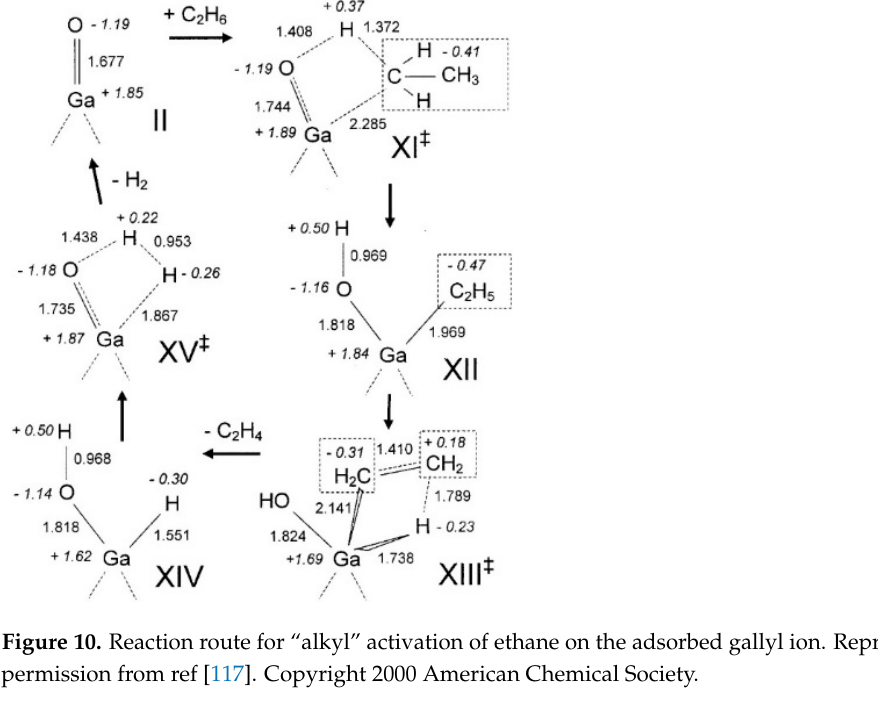
Figure 9. Reaction route for “alkyl” activation of ethane on [GaH 2 ] + . Reprinted with permission from ref [117]. Copyright 2000 American Chemical Society.